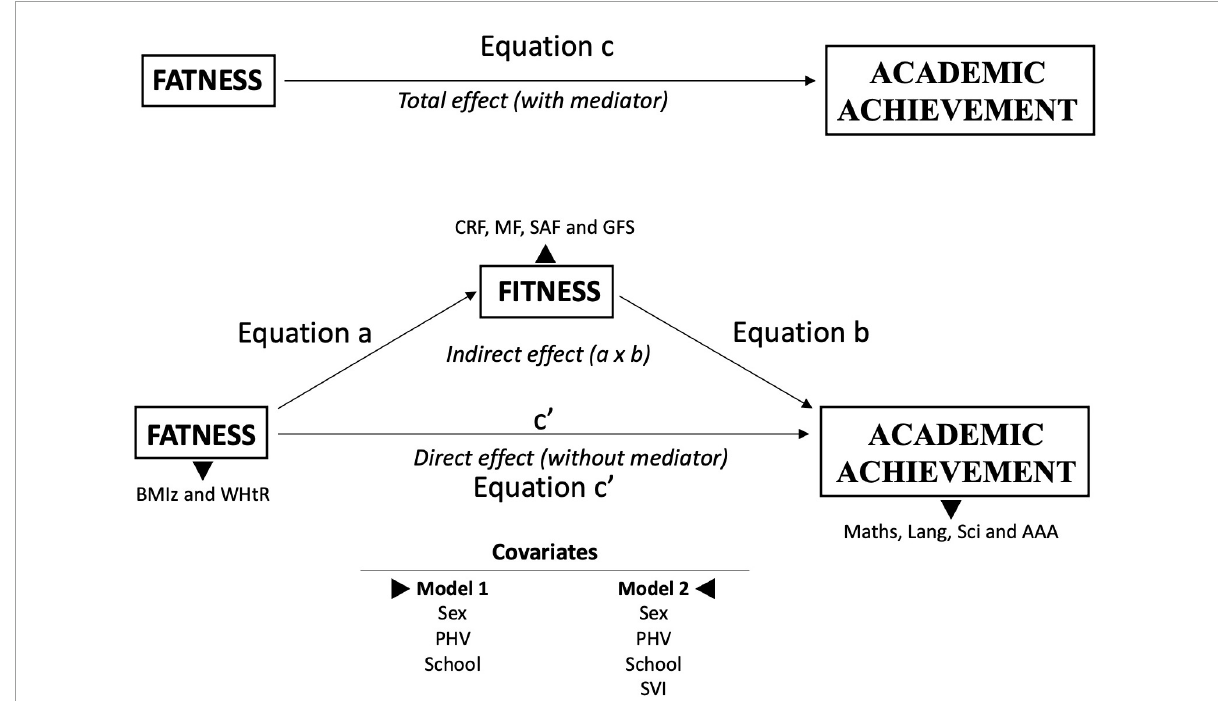
FIGURE1 Theoretical approach and general mediation model. BMIz, body mass index ( Z -score); WHtR, waist-to-height ratio; CRF, cardiorespiratory fitness; MF, muscular fitness; SAF: speed-agility fitness; GFS, global fitness score; sex; PHV, peak height velocity; school; SVI, school vulnerability